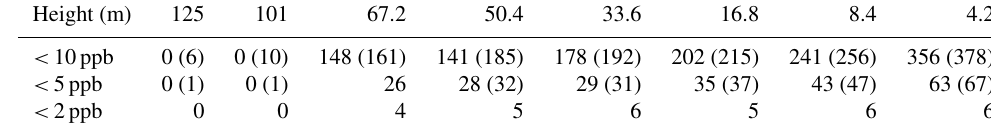
Table 1. The number of ozone depletion events seen at different heights that last for more than 3h. Ozone depletion events were classified as concentration drops below 10, 5, 2, and 1ppb. The statistics were based on the original 10min data. Statistics based on gap-filled data are presented in parentheses. The gap-filling procedure resulted in no significant changes in the statistics of depletion events for heights of